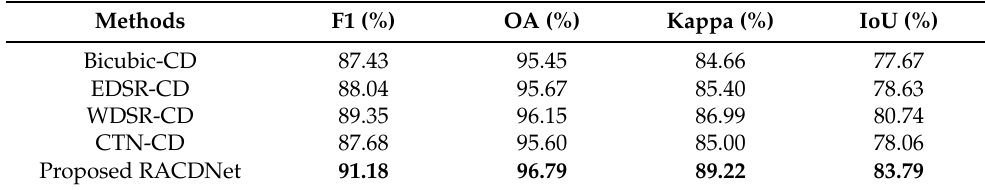
Table 5. Quantitative performance of CD results based on different super-resolution methods. The best values are in